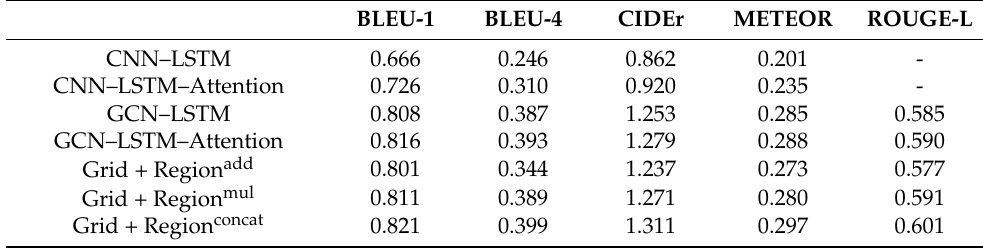
Table 2. Performance of frame